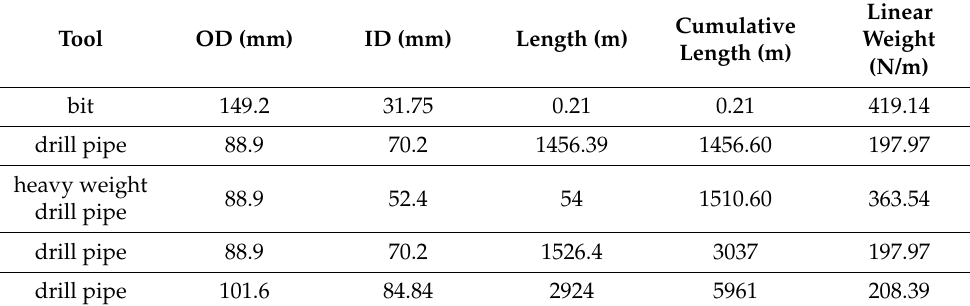
Table 8. Current bottom hole assembly (BHA) for well N open hole.